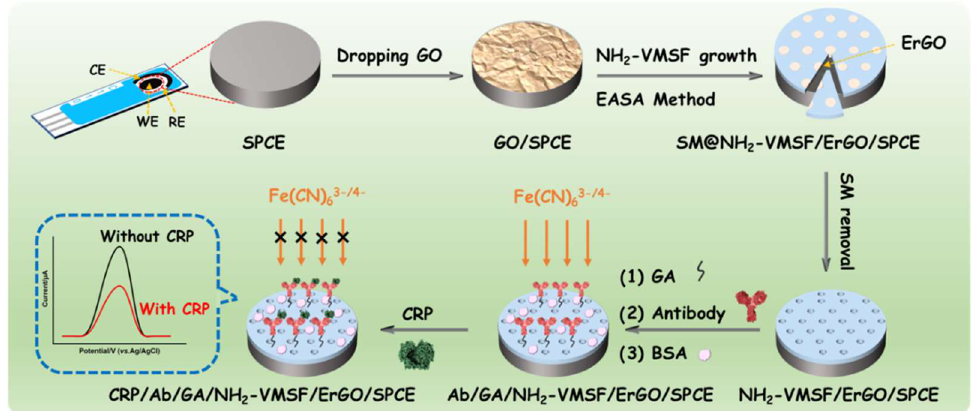
Figure 1. Schematic illustration for fabrication of electrochemical immunosensor on NH 2 -VMSF modified SPCE and the detection of CRP based on gated electrochemical signal.